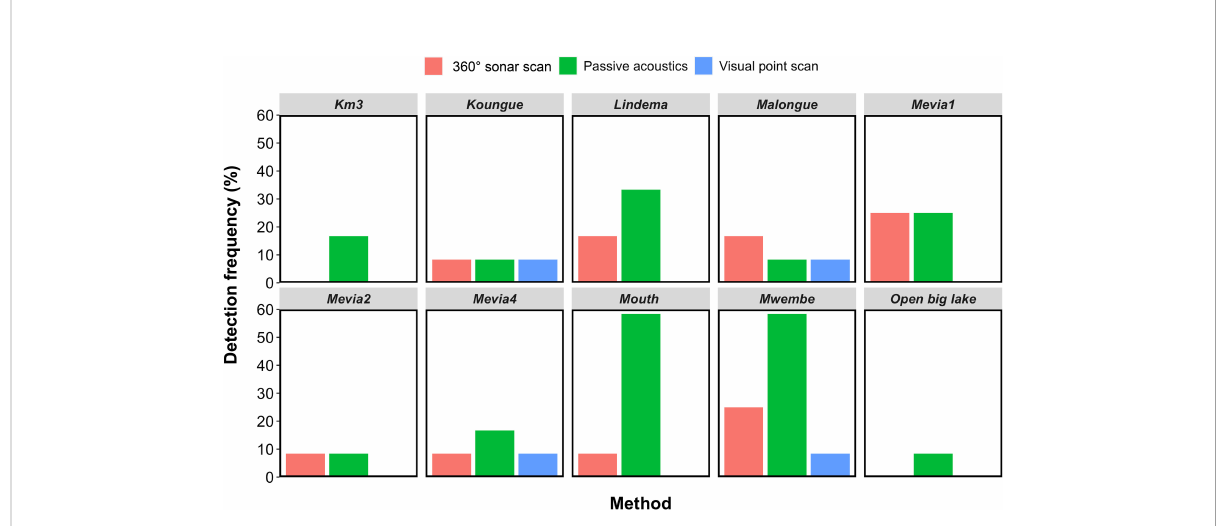
FIGURE 5 African manatee detection frequency (%) of visual point scan, 360° sonar scan and passive acoustics at 10 sites of Lake Ossa. Each site was sampled monthly for 12 months (n = 12 surveys per